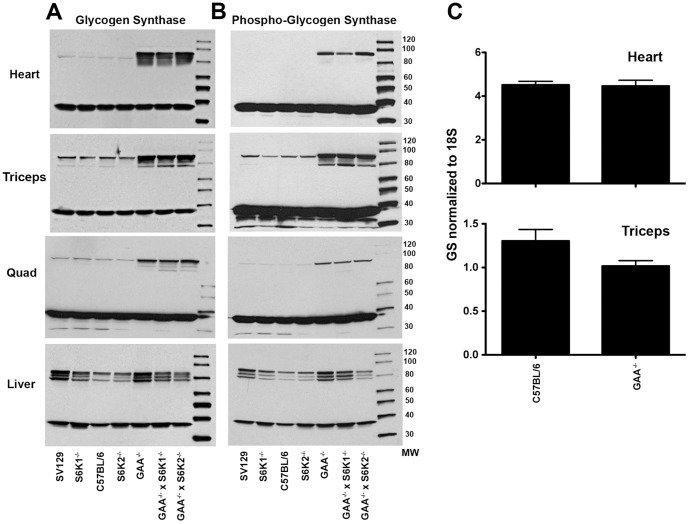
Muscle glycogen synthase protein is elevated in GAA−/− mice.Tissue lysates were prepared for the indicated tissues from each mouse strain. Lysates from 5 mice were pooled and 100 µg of protein from the pooled lysate was analyzed by Western blot analysis. All of the blots were probed with an anti-GAPDH antibody (∼37 kDa in all panels) to verify equal protein loading of all the test samples. (A) An anti-muscle glycogen synthase antibody was used to probe the blots containing samples from the heart, triceps, and quad. An anti-liver glycogen synthase antibody was used to probe the blot containing samples from the liver. (B) An anti-phospho-glycogen synthase (Ser641) antibody was used to probe the blots for phosphorylated GS. (C) Glycogen synthase transcript levels are not elevated in GAA−/− mice compared to wild type animals. RNA was isolated from triceps and heart of C57Bl/6 and GAA−/− mice and probed with qPCR primers as described under “Experimental Procedures.” Values shown are means ± SEM.